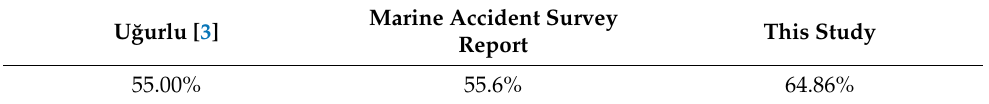
Table 6. Probabilities of primary